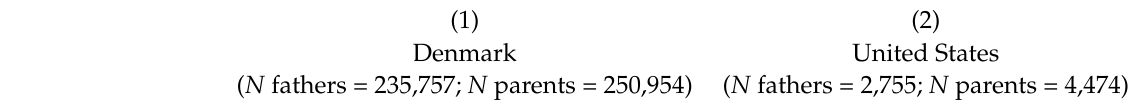
Table 4: Educational mobility by continuous measures. Children’s years of education (2013) by parents’ years of education, coded from the highest degree attained. Correlations and beta coefficients for the 1980–1984 cohorts, with separate models for each